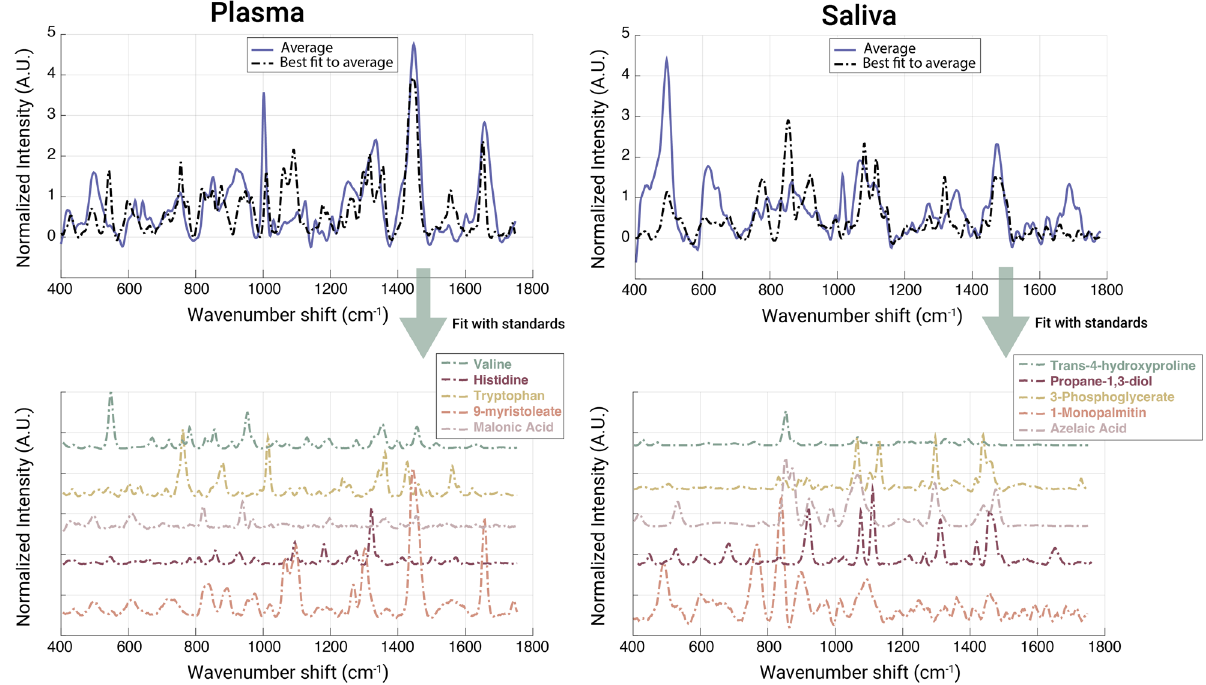
Figure 3. Raman spectra of cancer biofluids contain distinct features that can be attributed to the metabolites identified by GC-MS to drive diagnostic model performance. For each biofluid, average spectra of the cancer samples were fit with their respective metabolites. The average plasma cluster for cancer patients (blue) was fit with the reference spectra below for valine (green), histidine (magenta), tryptophan (yellow), 9-myristoleate (orange), and malonic acid (rose). The average saliva cluster for cancer patients (blue) was fit with the reference spectra below for trans-4-hydroxyproline (green), propane-1,3-diol (magenta), 3-phosphoglycerate (yellow), 1-monopalmitin (orange), and azelaic acid